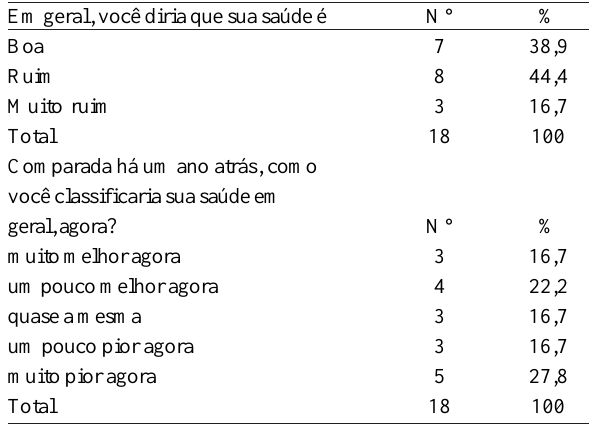
Tabela 3. Distribuição das frequências simples e relativas